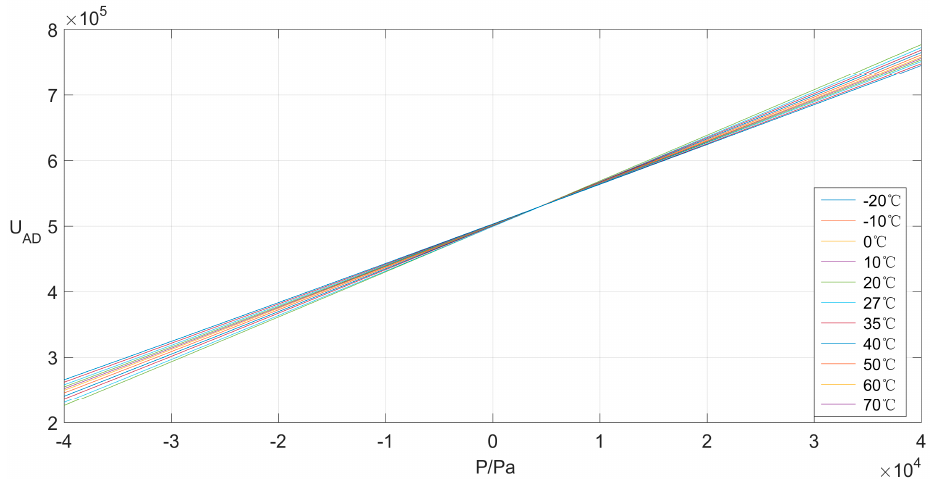
Figure 5. Pressure sensor’s output at different temperature.